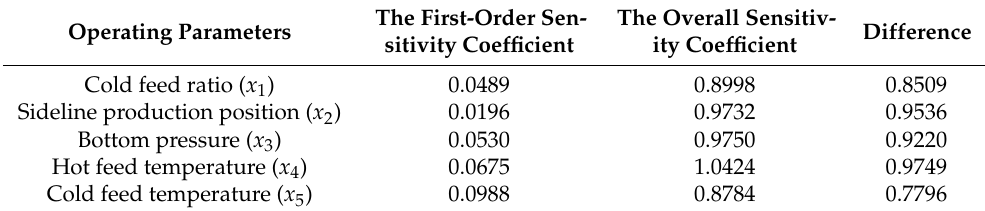
Table 4. Global sensitivity coefficients.